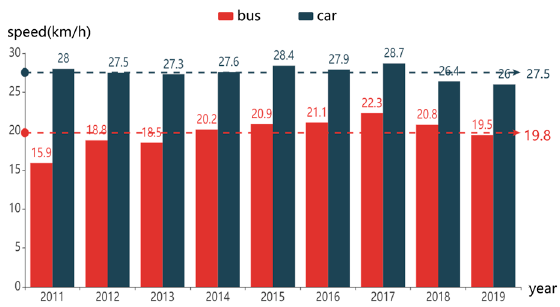
Figure 1. Average speed of cars and buses during peak hours in Shenzhen from 2011 to 2019.